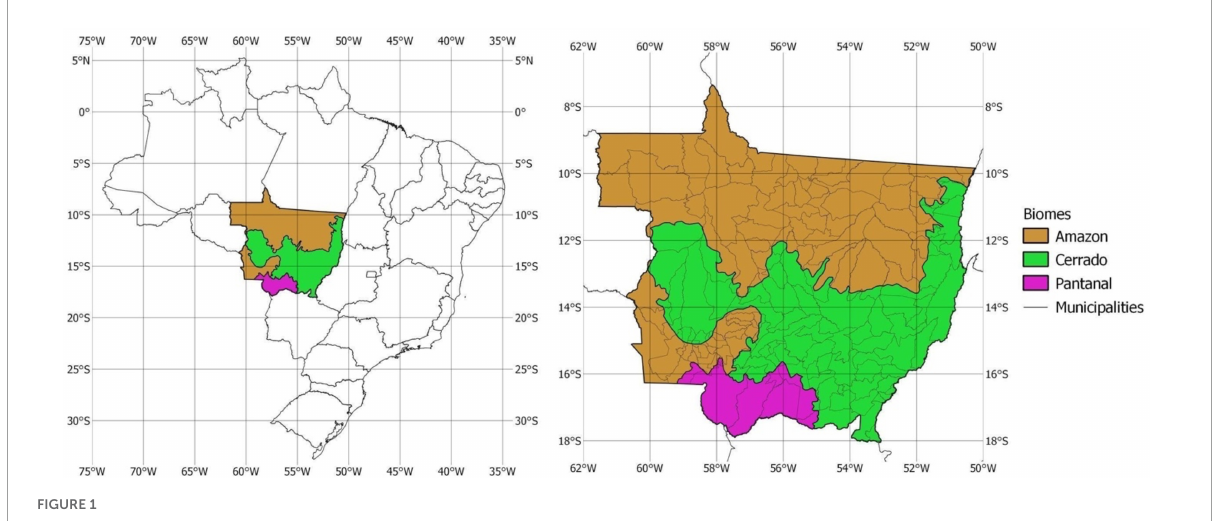
FIGURE1 Study area: Mato Grosso and its